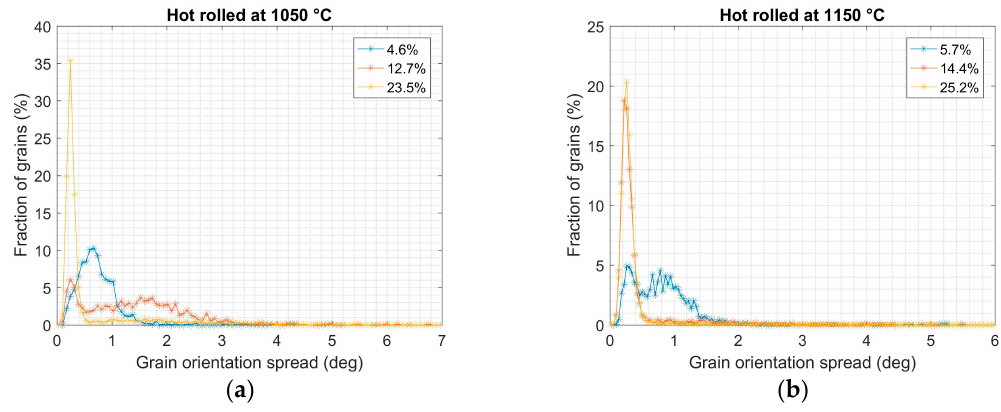
Figure 2. GOS for plates hot rolled at 1050 °C with deformation levels of 4.6%, 12.7% and 23.5% ( a ) and hot rolled at 1150 °C with deformation levels of 5.7%, 14.4% and 25.2% ( b ).